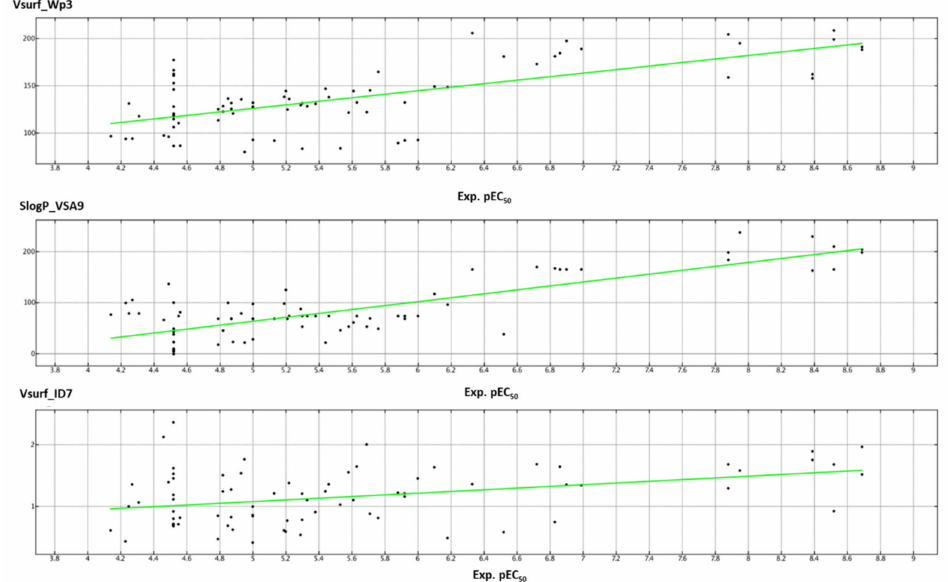
Figure 15. Distribution of the Vsurf_Wp3 ( top ), SlogP_VSA9 ( middle ) and Vsurf_ID7 ( bottom ) descriptor values with respect to the experimental (Exp.pEC 50 ) potency data of the dataset compounds (shown as black